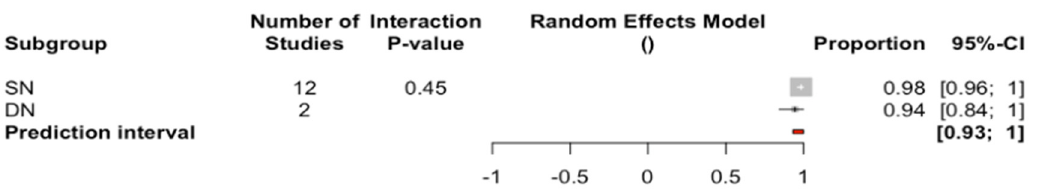
Figure 3. Forest plot of root canal location success rate compared between computer-aided navigation techniques. The horizontal axis expresses the root canal proportion success rate of each computer-aided navigation technique.